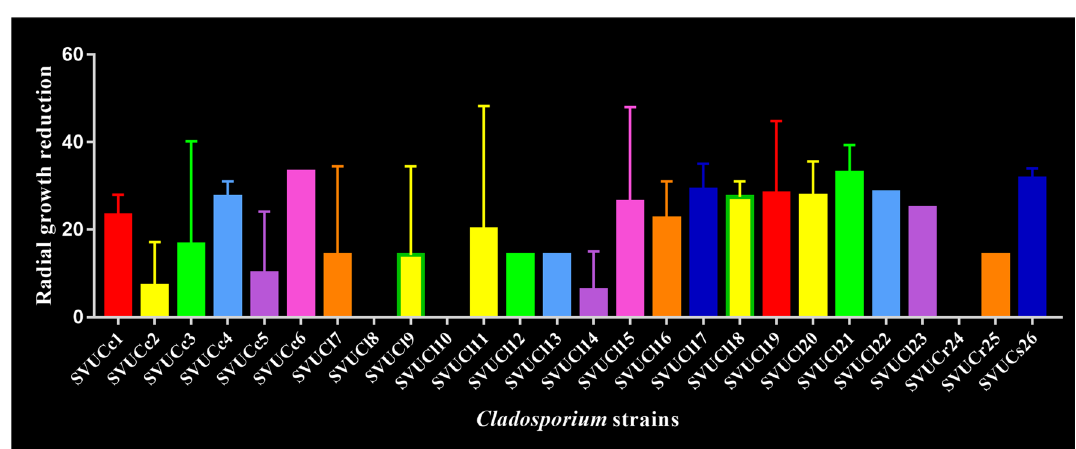
Figure 7. Inhibitory effect of C. globosum on the growth of Cladosporium